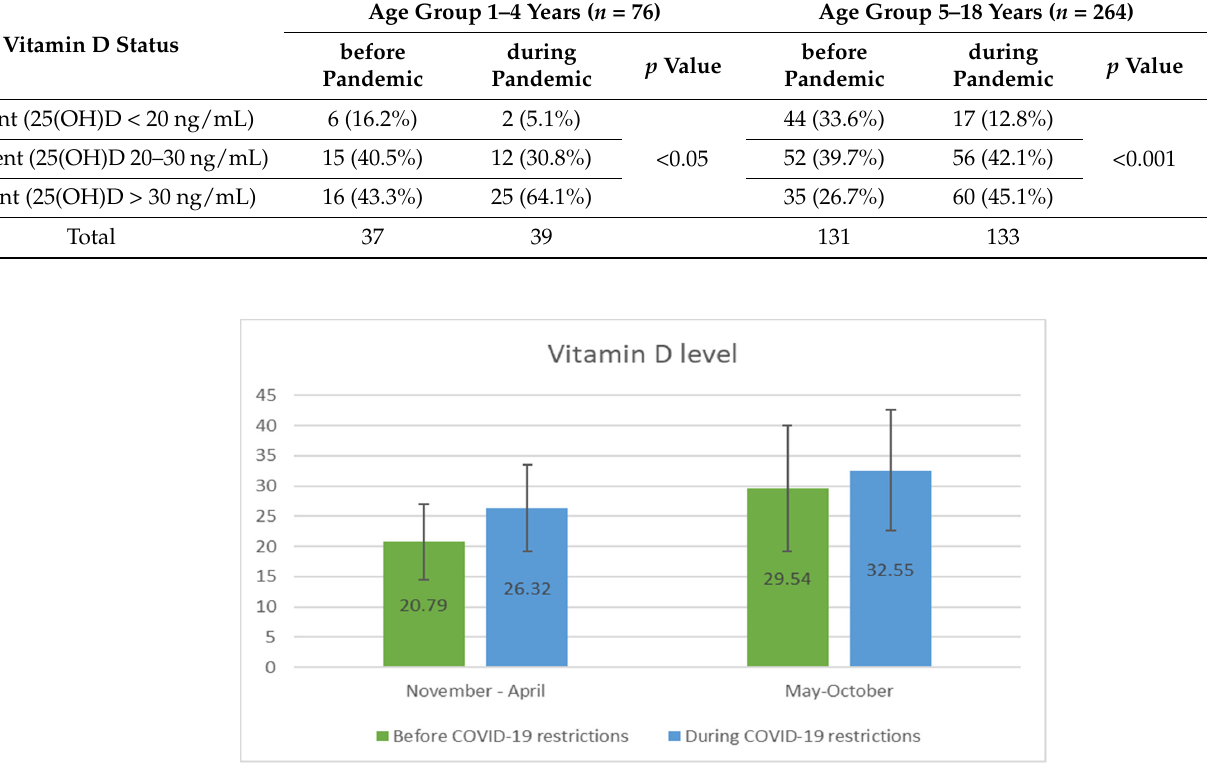
Figure 4. Box plot showing the level of vitamin D (25(OH)D, ng/mL) before and during COVID-19 restrictions, according to season of determination. The differences were statistically significant ( p <